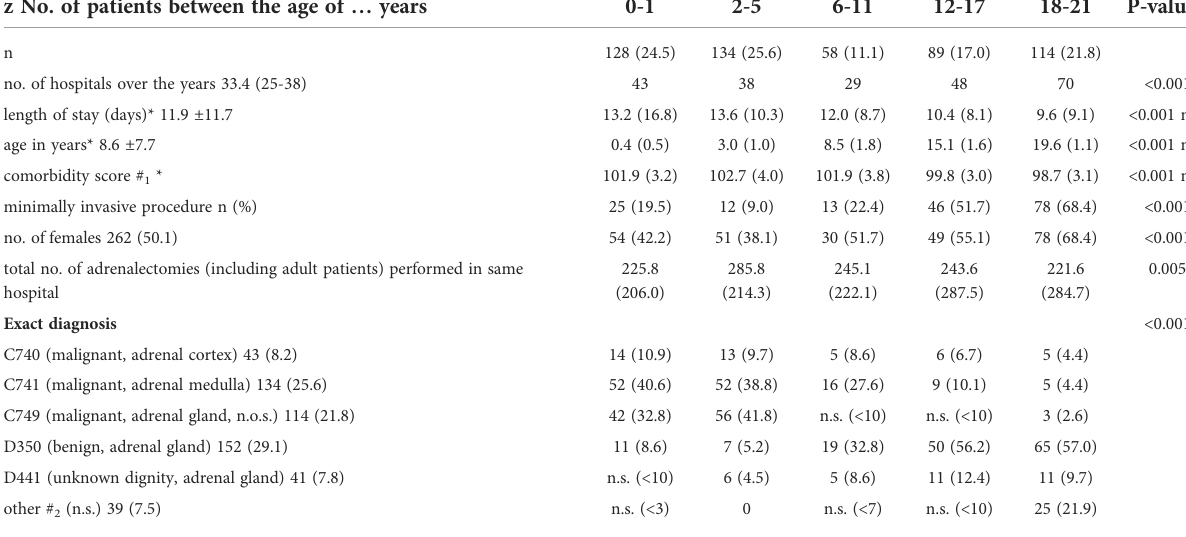
TABLE 1 Patients ≤ 21 years of age: patient characteristics by age groups. z No. of patients between the age of … years